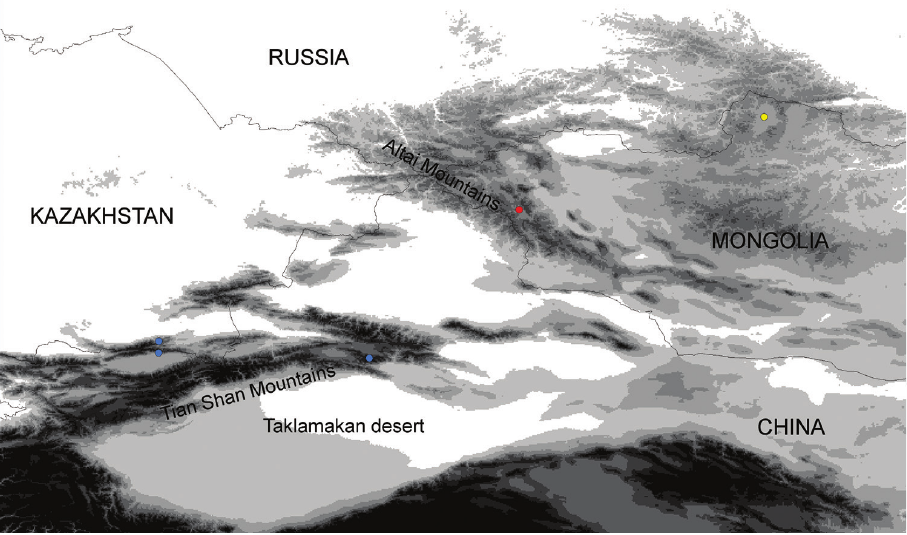
Figure 6. Distribution of investigated specimens of Udea juldusalis (blue), U. altaica (red) and U. plumbalis (yellow) in Central Asia; altitudes ³ 1,000 m are marked in increasingly darker grey shades every 500 m, altitudes ³ 4,000 m are in black. Note that the eastern locality of U. juldusalis and the localities of U. altaica and U. plumbalis are only approximations of the type